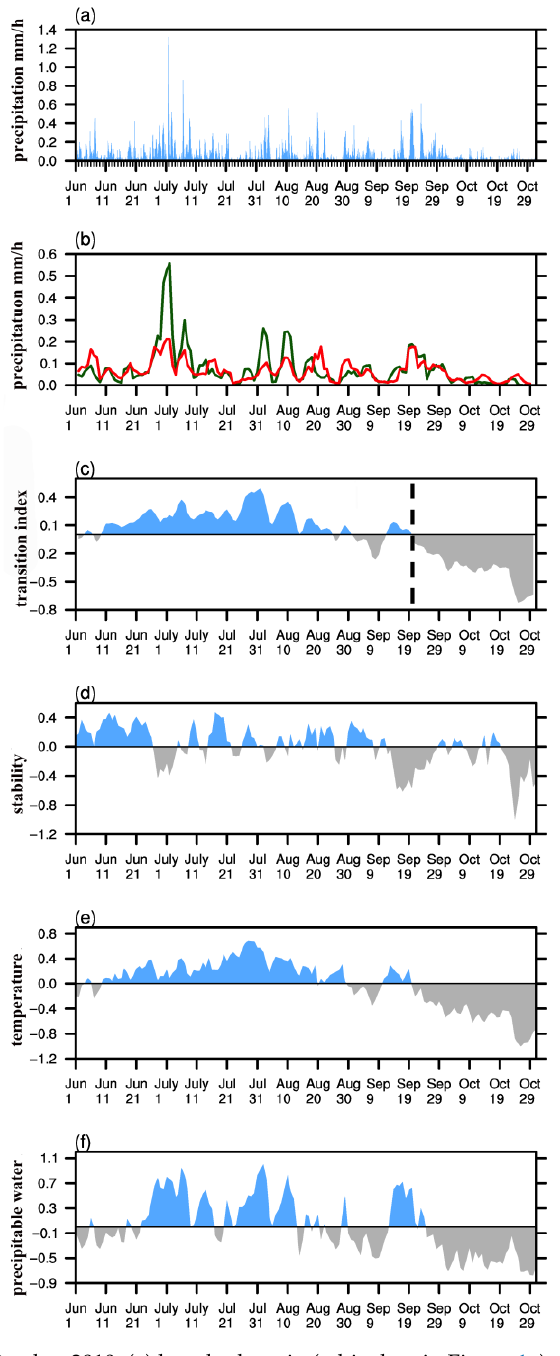
Figure A2. For June–October 2010, ( a ) hourly domain (white box in Figure 1a) averaged precipitation; ( b ) 3-day running mean of nighttime (20:00–08:00, dark green line) and daytime (08:00–20:00, red line) rainfall; ( c ) 3-day running mean of transition index anomaly (TI); normalized domain averaged ( d ) atmospheric stability anomaly, ( e ) 2 m temperature anomaly, and ( f ) precipitable water anomaly. The black dashed line in ( c ) indicates transition date 21 September 2010.